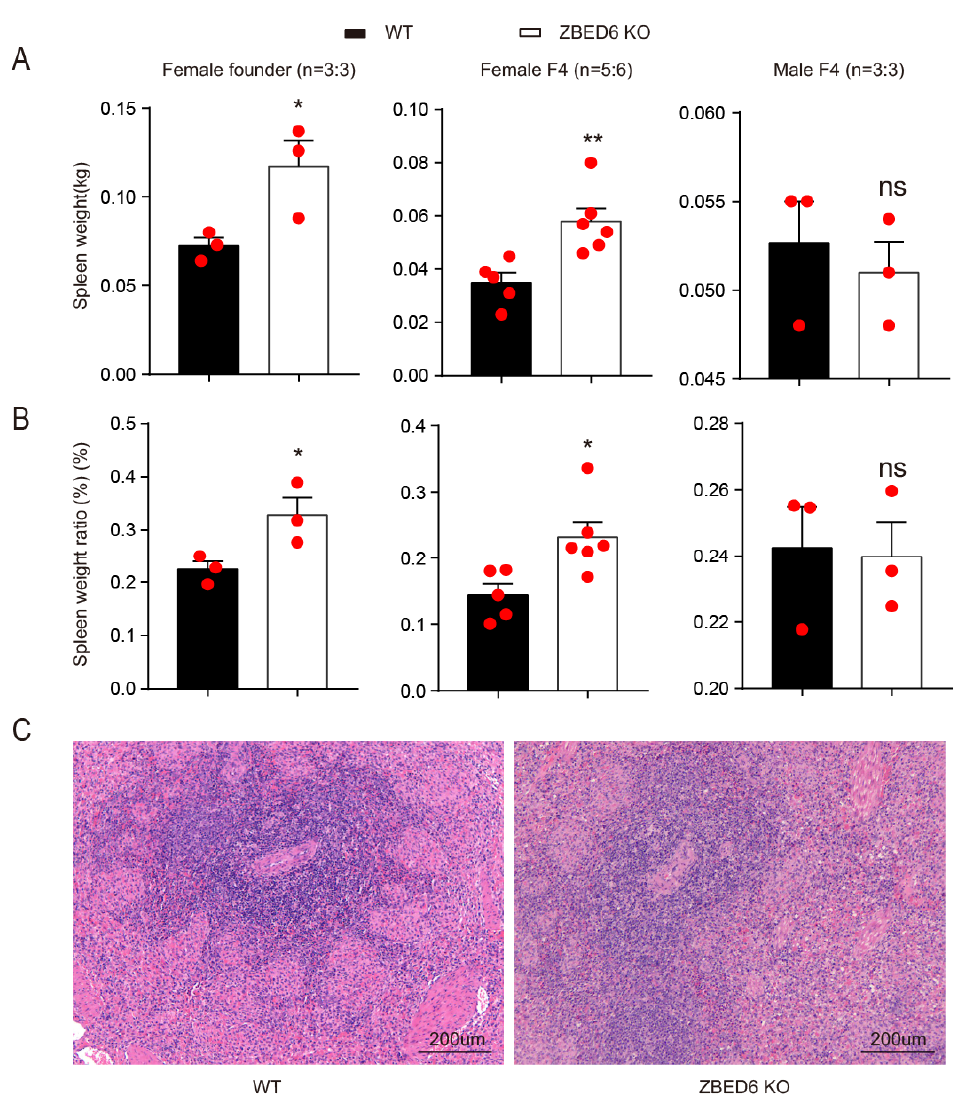
Figure 1. Spleen phenotypes of ZBED6 KO founder and F4 pigs. ( A , B ) The phenotypes of WT and ZBED6 KO in terms of spleen weight and ratio. Red points indicate actual phenotype data. ( C ) The results of spleen HE staining in WT and ZBED6 KO founder pigs. Scale bar = 200 μ m; **, p < 0.01; *, p < 0.05.